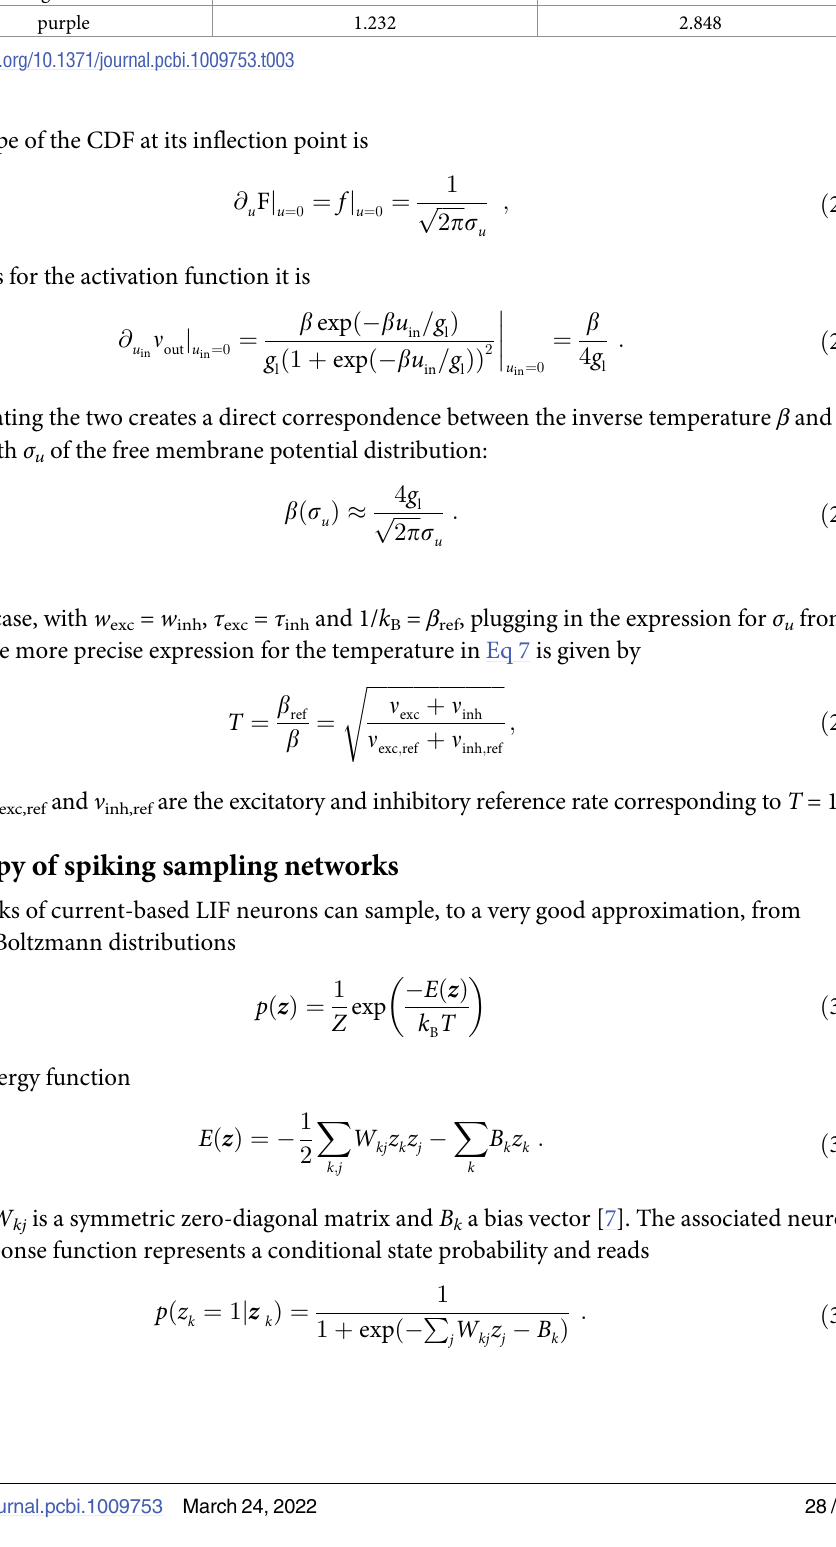
Table 3. Background parameters for the colored response functions and membrane potential distributions in Fig 1. color ν exc (kHz) ν inh (kHz) blue 1.000 1.000 orange 2.000 2.000 red 4.000 4.000 green 2.848 1.232 purple 1.232